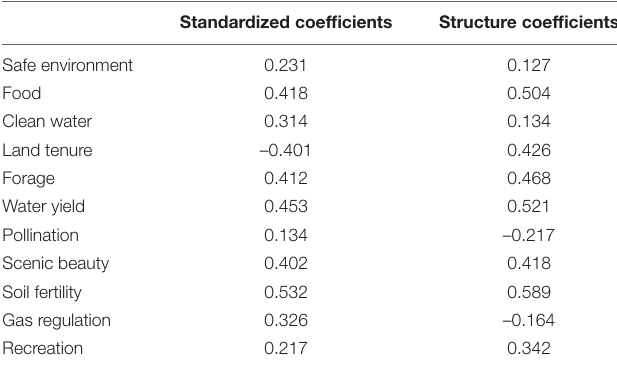
TABLE 8 | Standardized and structure coefficients of the independent variables.